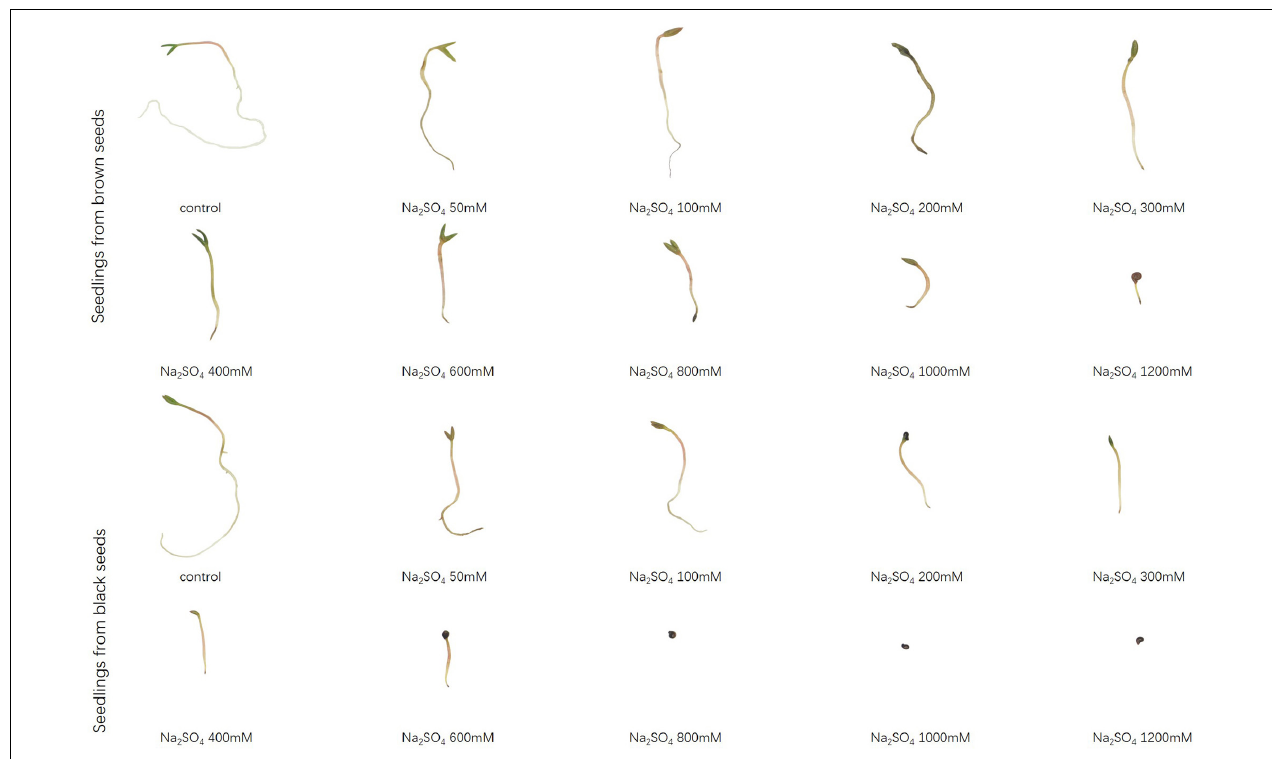
FIGURE 7 | Radicle elongation of seedlings grown from dimorphic seeds of S. salsa after 20 days of incubation under different concentrations of Na 2 SO 4 . TABLE 5 | Shoot tolerance index of S. salsa seedlings grown from dimorphic seeds treated with different concentration of NaCl or Na 2 SO 4 . Concentration (mM) NaCl Na 2 SO 4 Seedlings from brown seeds Seedlings from black seeds Seedlings from brown seeds Seedlings from black seeds 0 100 . 0 ± 3 . 4